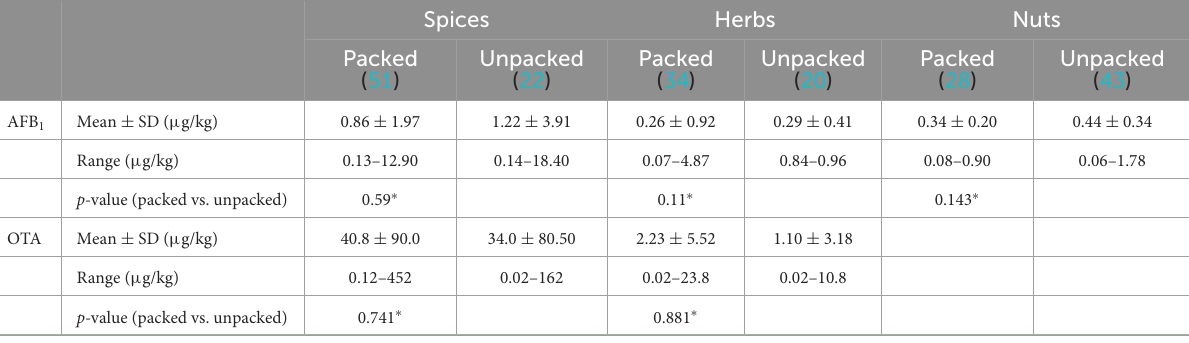
TABLE 6 Mean and range of contamination of AFB 1 and OTA in vacuum packaged vs. unpackaged samples of spices, herbs, and nuts. Spices